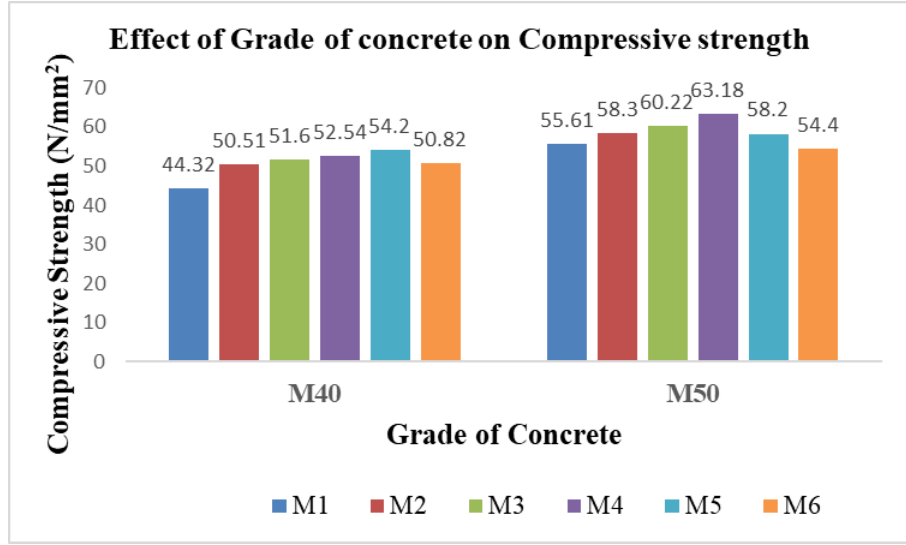
Figure 7. Comparison of the compressive strength of various specimens of different grades.